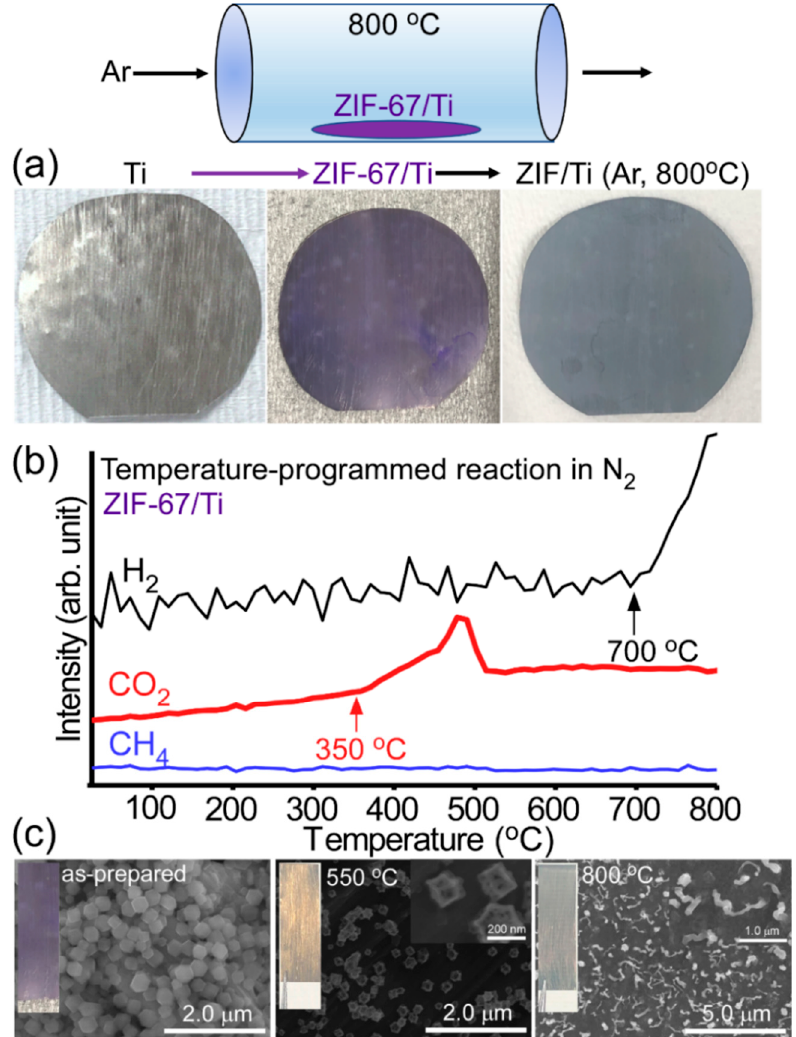
Figure 1. Schematic of a reaction setup and photos of the samples at each stage ( a ); temperature- programmed reaction profiles ( b ) of H 2 , CO 2 and CH 4 for ZIF-67/Ti sheet; and SEM images ( c ) of as-prepared ZIF-67/Ti and after thermal treatments of 550 ◦ C and 800 ◦ C, respectively. The TPR signal (Figure 1b) of H 2 (mass = 2 amu) started to increase at 700 ◦ C, which was attributed to the association of adsorbed H, followed by H 2 release. The CH 4